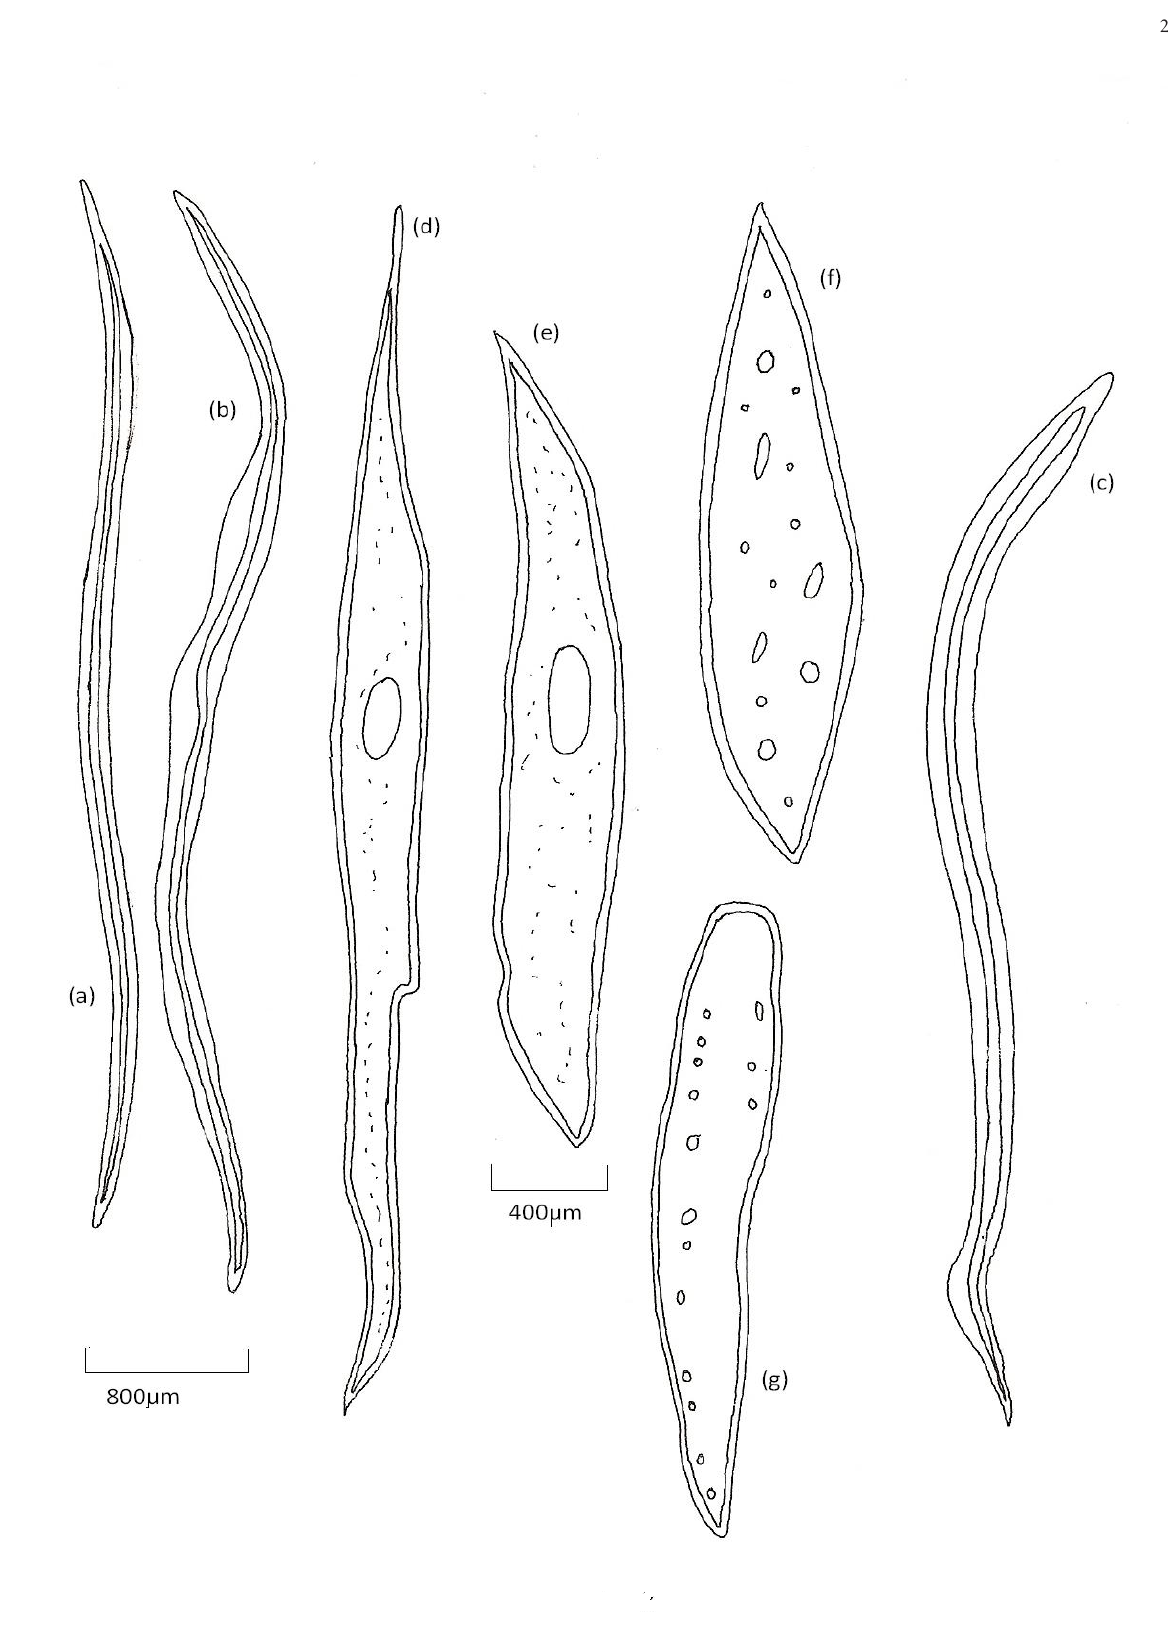
Fig. 2. Diagrammatic illustration of Fibre types in Annona senegalensis ; Diagram a-c: Libriform fibres in Annona senegalensis ; Dia- gram d-e: Simple slit-like pitted Fibre-tracheid in Annona senegalensis ; Diagram f-g: Simple circular-like pitted tracheid-fibres in Annona